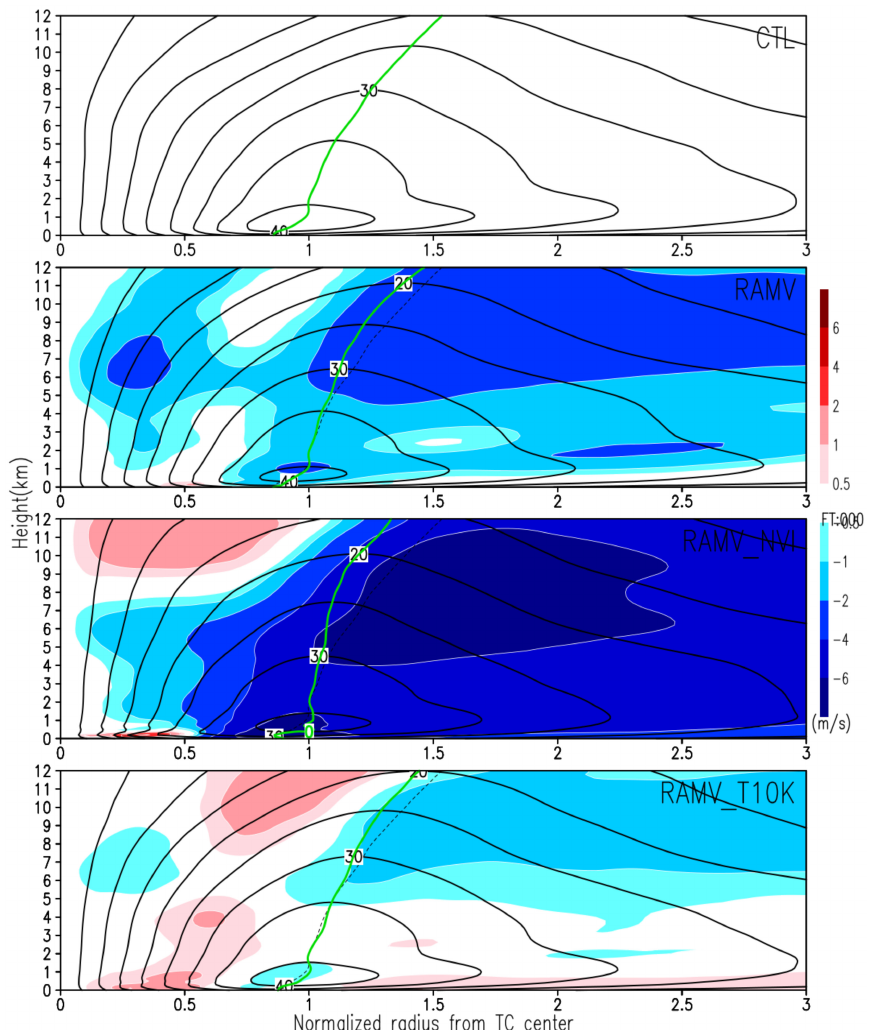
Figure 8. Radial-height cross section of azimuthally averaged tangential wind (contour) at the initial (FT = 0) for Meranti. Color shading display the di ff erence in azimuthally averaged wind (each experiment minus CTL). Green and black dashed lines indicate the radius of maximum wind (RMW) at each height for each experiment and CTL,